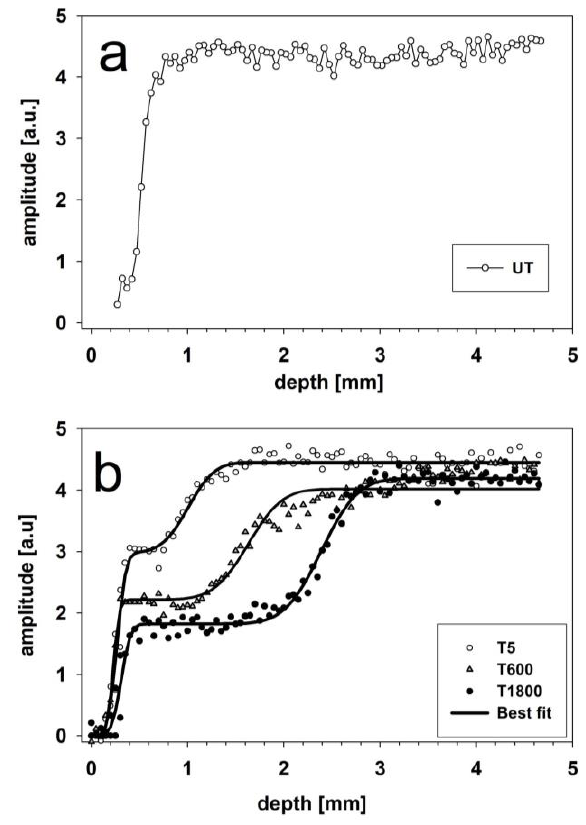
Figure 6. ( a ) 1 H NMR depth profile collected on a water-saturated untreated sandstone specimen (UT); ( b ) Profiles collected on water-saturated sandstone specimens treated with dimethylsiloxane (DMS) for 5 s (T5), 600 s (T600), and 1800 s (T1800). Adapted from [50]. Table 3. Parameters obtained fitting depth profiles to Equation (4) and slope at inflection points obtained from Equation